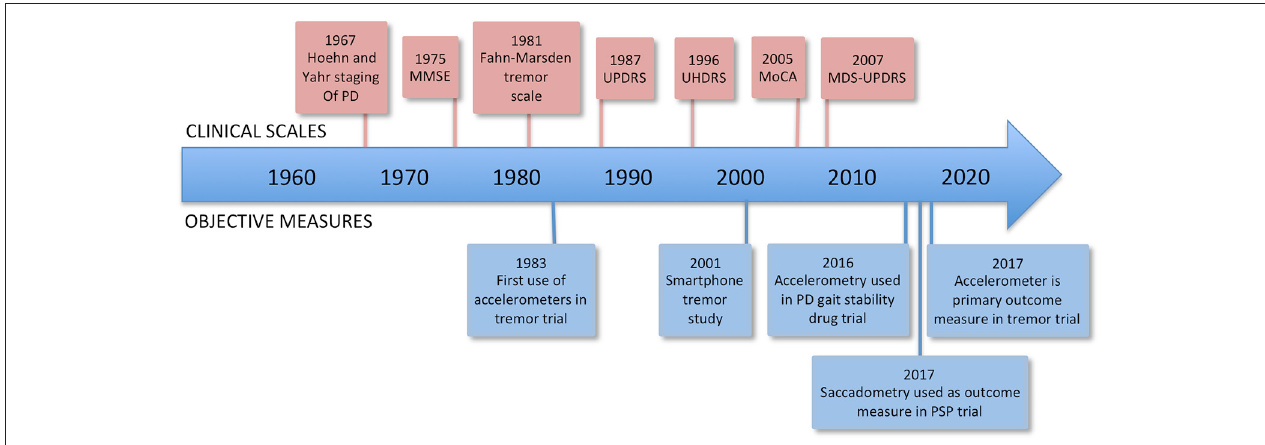
FIGURE 1 | Timeline of rating scales and significant firsts in the use of measurement technology. MMSE, Mini-Mental State Examination; UPDRS, Unified Parkinson’s Disease Rating Scale; UHDRS, Unified Huntington’s Disease Rating Scale; MoCA, Montreal Cognitive Assessment; MDS-UPDRS, Movement Disorders Society Unified Parkinson’s Disease Rating